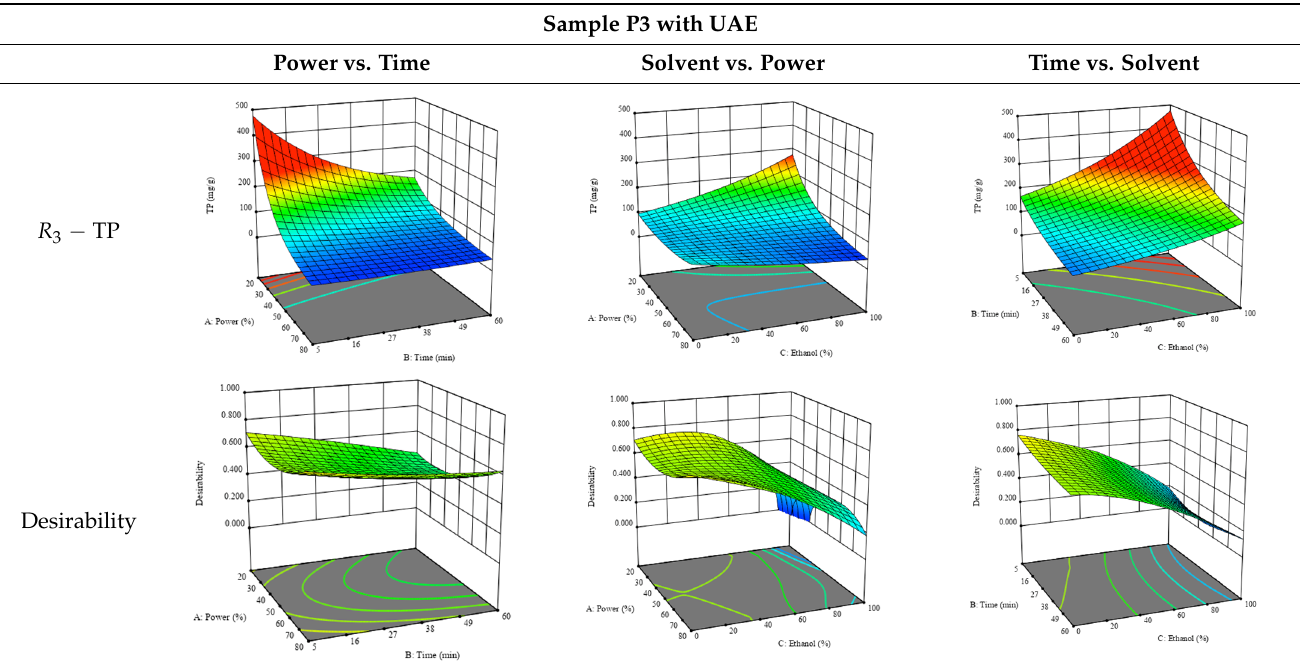
Table 10. Cont. Power vs.